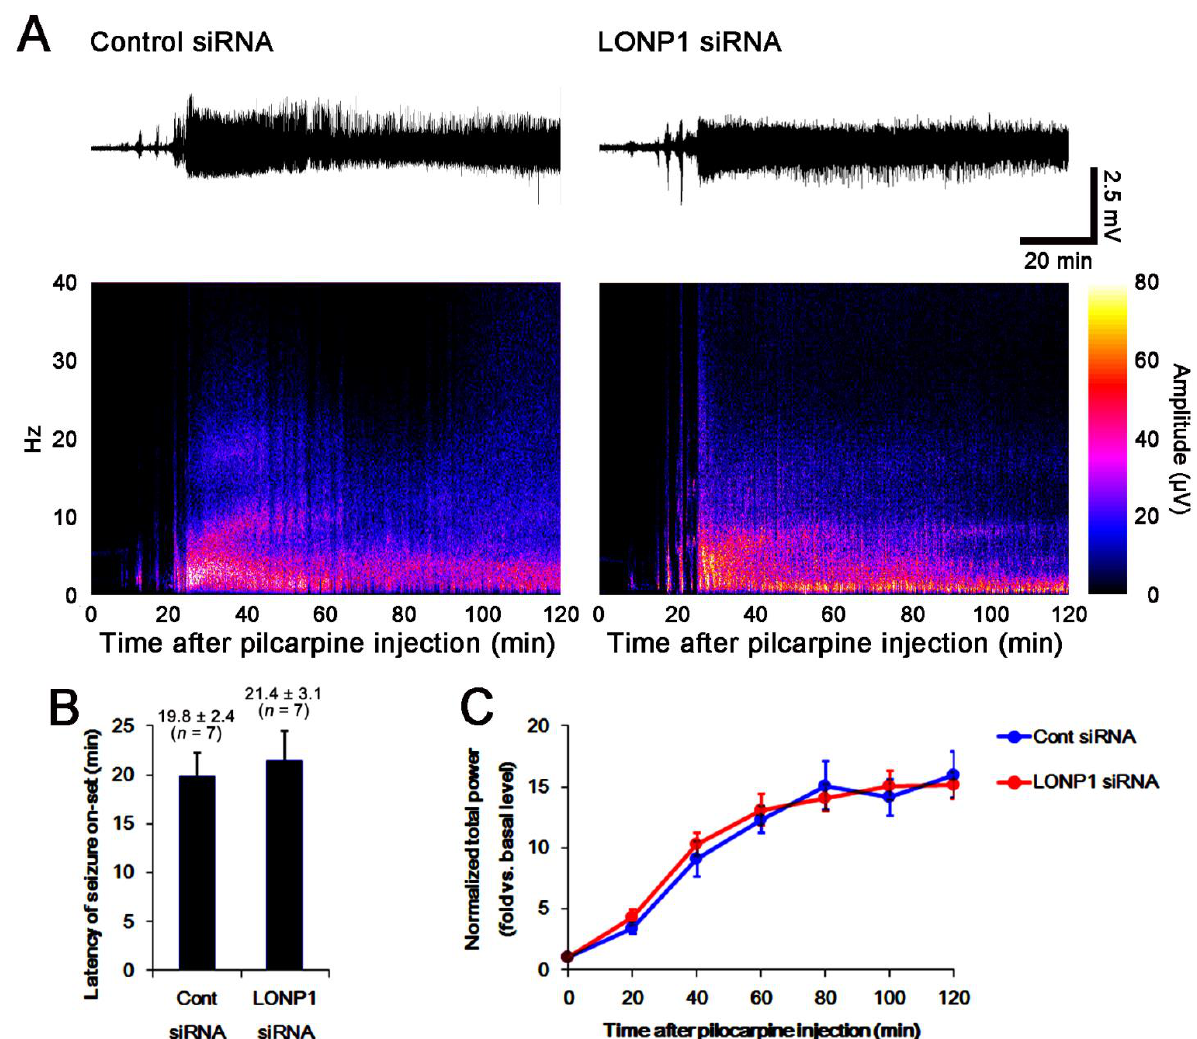
Figure 3. Effects of control siRNA and LONP1 siRNA on seizure activity in response to pilocarpine. As compared to control siRNA (Cont siRNA), LONP1 siRNA does not affect seizure activity induced by pilocarpine. ( A ) Representative EEG traces and frequency power spectral temporal maps in response to pilocarpine. ( B , C ) Quantification of the latency of seizure onset (( B ), mean ± S.E.M.; Student’s t -test) and total EEG power (seizure intensity) in response to pilocarpine (( C ), mean ± S.E.M.; n = 7; repeated measures ANOVA).